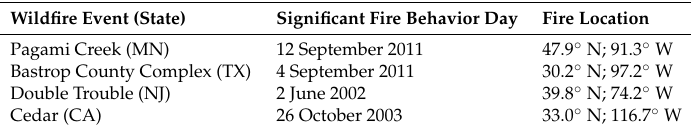
Table 1. Historical fires analyzed in this study.